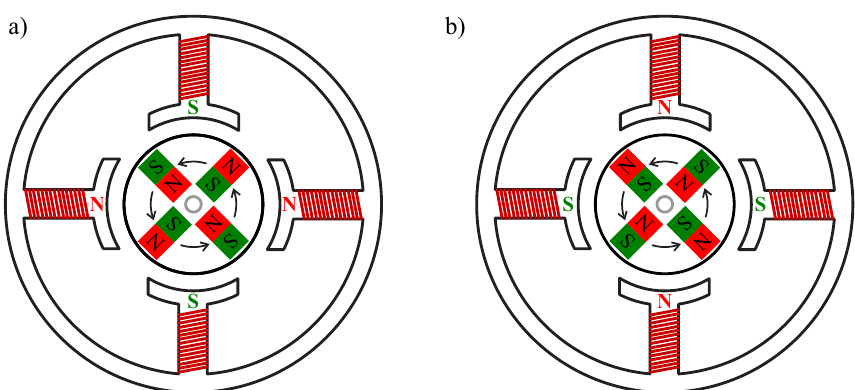
Figure 3. Principle of electromagnetic actuation of permanent magnets embedded in rotor (middle) through switching of the current direction through stator coils between state ( a ) and ( b ).